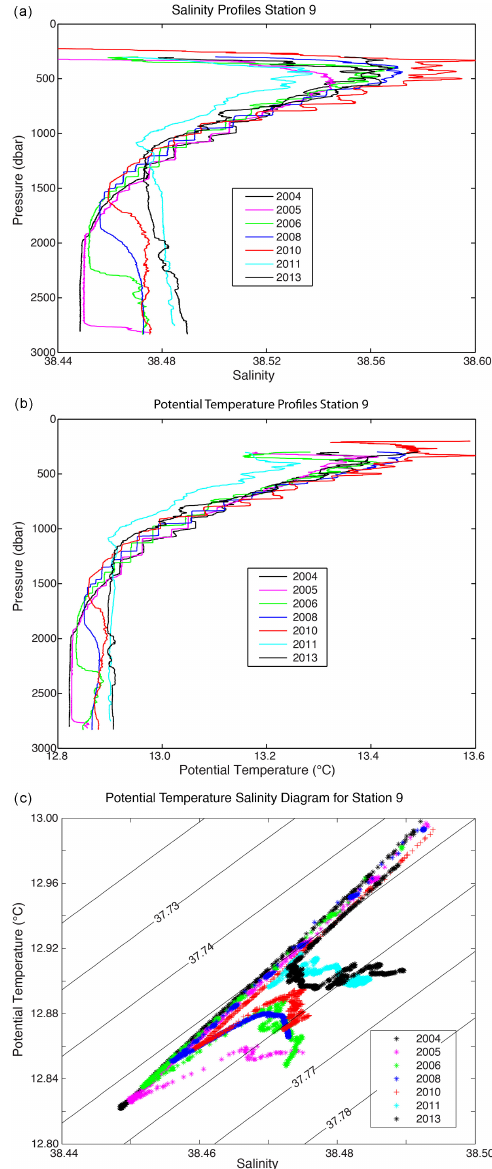
Figure 3. Profiles of (a) salinity and (b) potential temperature versus pressure for the repeat occupations at station 9; (c) po- tential temperature–salinity diagrams for these recent stations be- low 1000dbar with contours of potential density referenced to 2000dbar. Levantine Intermediate Water (LIW) is evident as a salin- ity maximum at about 400dbar for each station. Western Mediter- ranean Deep Water (WMDW) is the deep water below 1800dbar at each station. The halocline–thermocline between the depth of the LIW at 400dbar and the top of the deep water below 1500dbar has a stratification where warm, saltier waters overlie colder fresher waters and this stratification is conducive to salt finger mixing pro- cesses. Depth-averaged salinity, potential temperature and potential density referenced to 2000dbar over 1900–2750dbar and 1500– 1900dbar are given for each station in Table